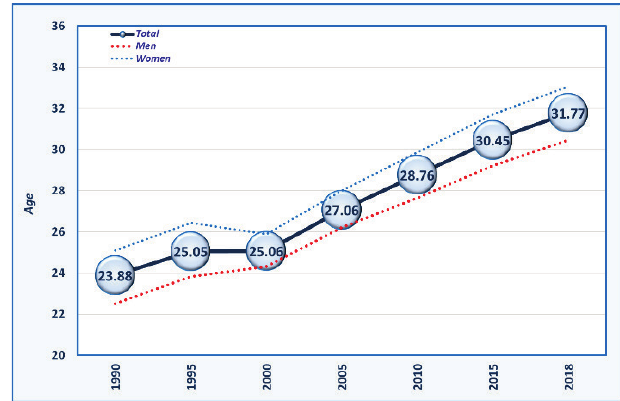
Figure 24. Median age in Azerbaijan. Source: according to SSC